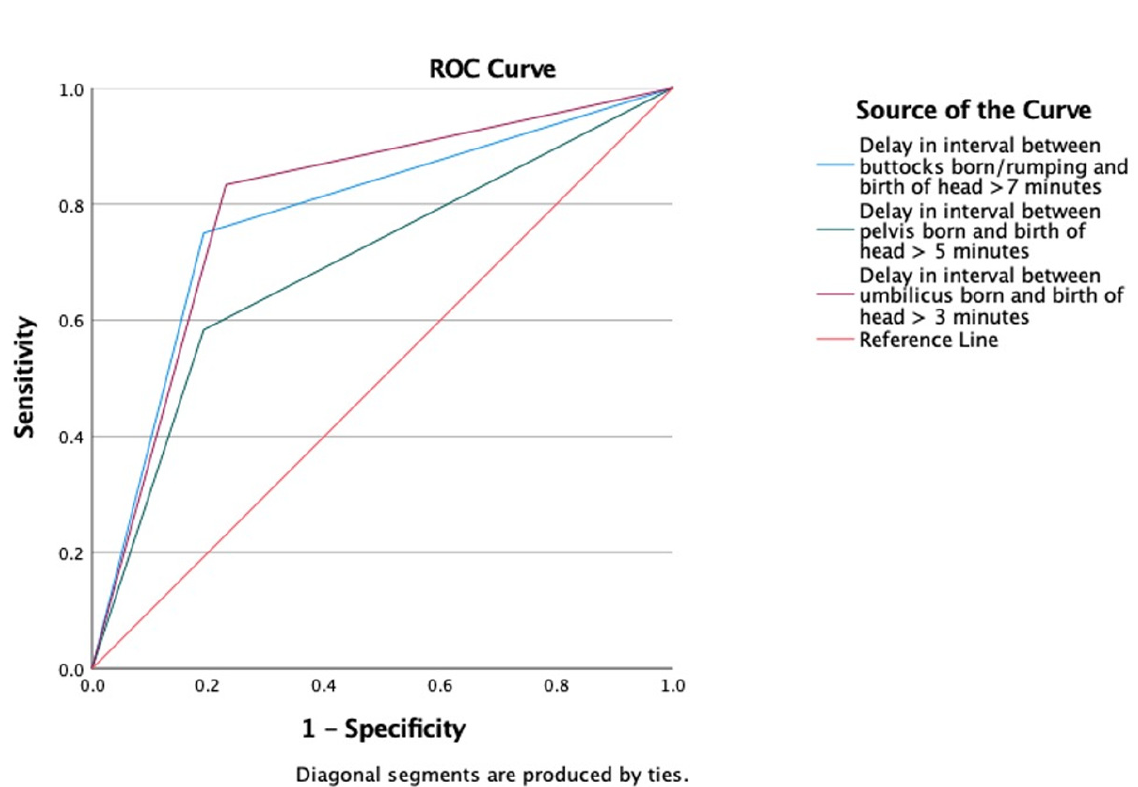
Figure 2. Predictive value of Physiological Breech Birth Algorithm’s 7-5-3 time limits.